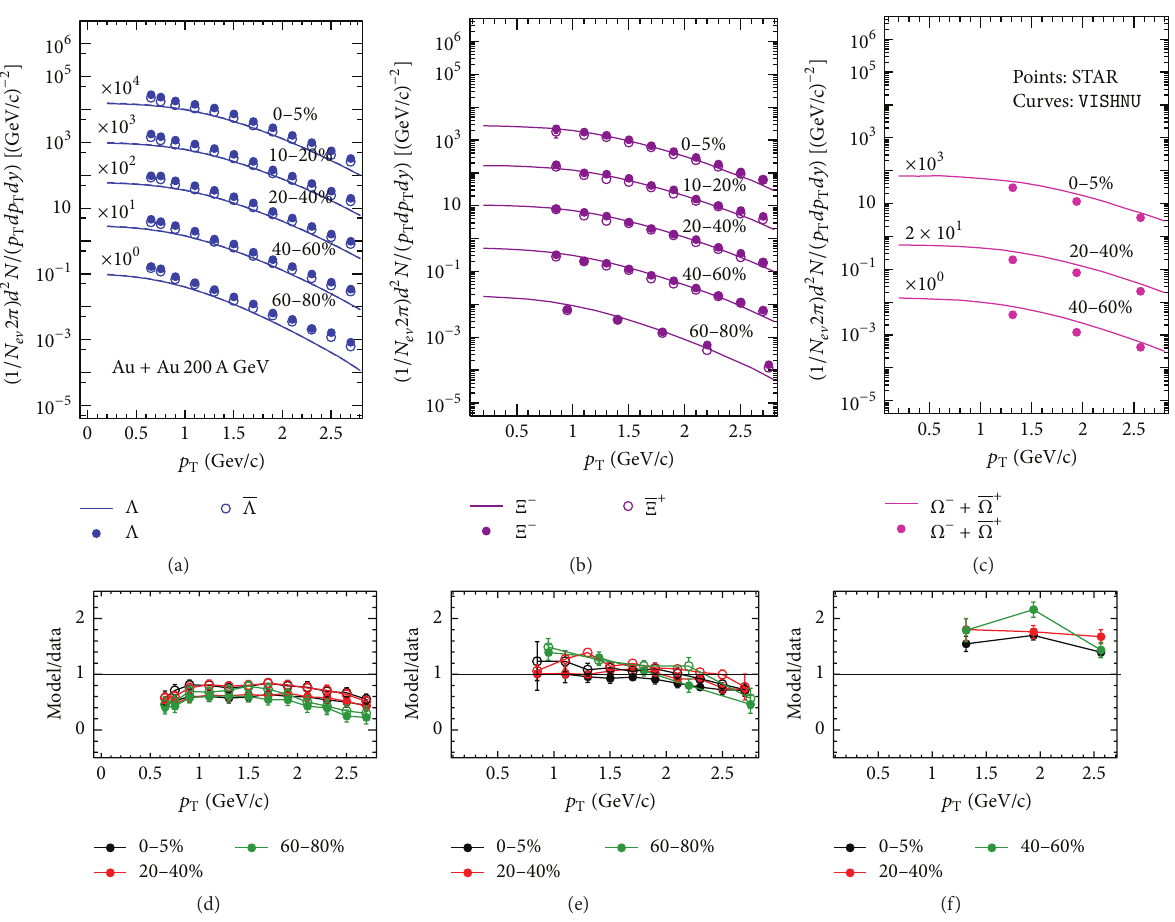
+ + Figure 1: Transverse momentum spectra of Λ ( Λ ), Ξ − ( Ξ ), and Ω − + Ω at various centralities in Au + Au collisions at √𝑠 NN = 200 GeV. Experimental data are taken from STAR measurements [15]. Theoretical curves are calculated by the VISHNU hybrid model with the parameterspresentedinSection2.Fromtoptobottomthecurvescorrespondto0–5%( ×10 4 ),10–20%( ×10 3 ),20–40%( ×10 2 ),40–60%( ×10 1 ), and 60–80% ( ×10 0 ) centrality, respectively, where the factors in parentheses are the multipliers applied to the spectra for clear separation. The multiplied factor for spectra of Ω at 20–40% is 2 × 10 1 instead of 1 × 10 1 . In VISHNU , the spectra of particles and corresponding antiparticles are the same due to zero net-baryon density used in our calculations. Therefore, only results of particles are shown with solid